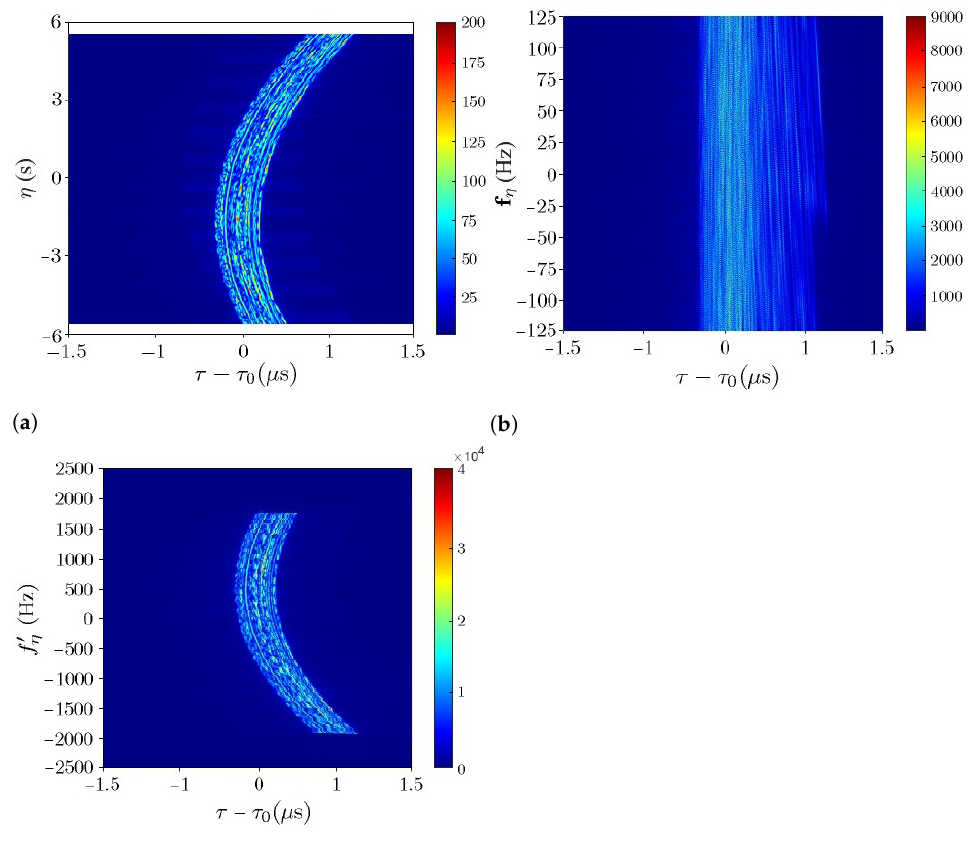
( τ , η ) , received 1 b ( τ , f (cid:48) ) , unwrapped η 9